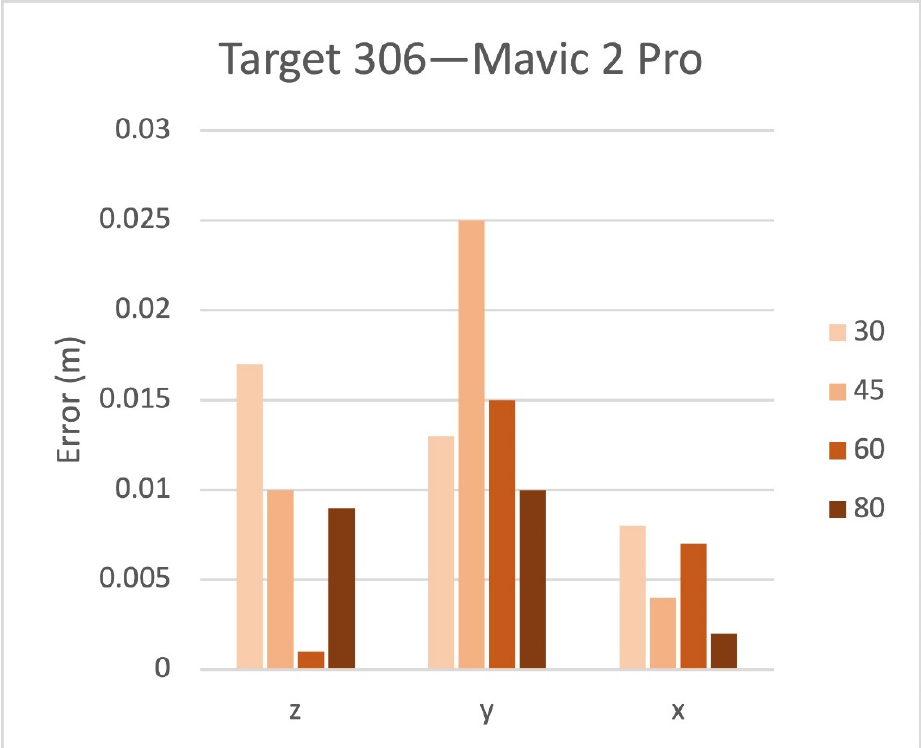
Figure 8. Residuals from the Mavic 2 Pro on CkP 306.